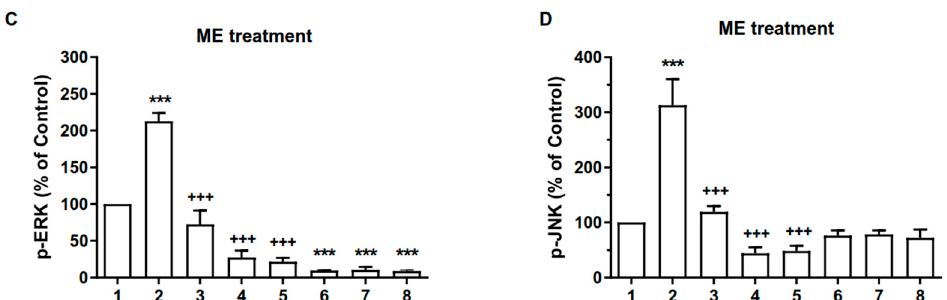
Figure 6. Effect of ME on p-JNK, p-ERK, and TNF- α , proteins in RAW 264.7 cells. ( A ) The expression levels of p-JNK, p-ERK, and TNF- α proteins were measured by performing Western blotting analysis. The Raw 264.7 cells were treated with ME for 24 h. 1—Normal group, 2—LPS-treated control group, 3—LPS-treated control group + 10 µ g/mL ME, 4—LPS-treated control group + 100 µ g/mL ME, 5—LPS-treated control group + 200 µ g/mL ME, 6—Normal group + 10 µ g/mL ME, 7—Normal group + 100 µ g/mL ME, 8—Normal group + 200 µ g/mL ME. Quantitative analysis of the results of the Western blotting analysis are shown in ( B ) for p-JNK, in ( C ) for p-ERK, and in ( D ) for TNF- α proteins. β -Actin was used as an internal control. Values are mean ± SEM ( n = 3). These values are expressed as the percentage of the control tested protein / β -actin for each sample. TNF- α ( B ): 1 vs. 2 p = 0.0016, 2 vs. 3 p = 0.0094, 2 vs. 4 p = 0.0077, 2 vs. 5 p = 0.0082; p-ERK ( C ): 1 vs. 2 p < 0.0001, 2 vs. 3 p < 0.0001, 2 vs. 4 p < 0.0001, 2 vs. 5 p < 0.0001, 1 vs. 6 p < 0.0001, 1 vs. 7 p < 0.0001, 1 vs. 8 p < 0.0001; p-JNK ( D ): 1 vs. 2 p = 0.0002, 2 vs. 3 p = 0.0004, 2 vs. 4 p < 0.0001, 2 vs. 5 p < 0.0001. (one-way ANOVA for multiple comparisons, ** p < 0.01, *** p < 0.001; ++ p < 0.01, +++ p < 0.001).